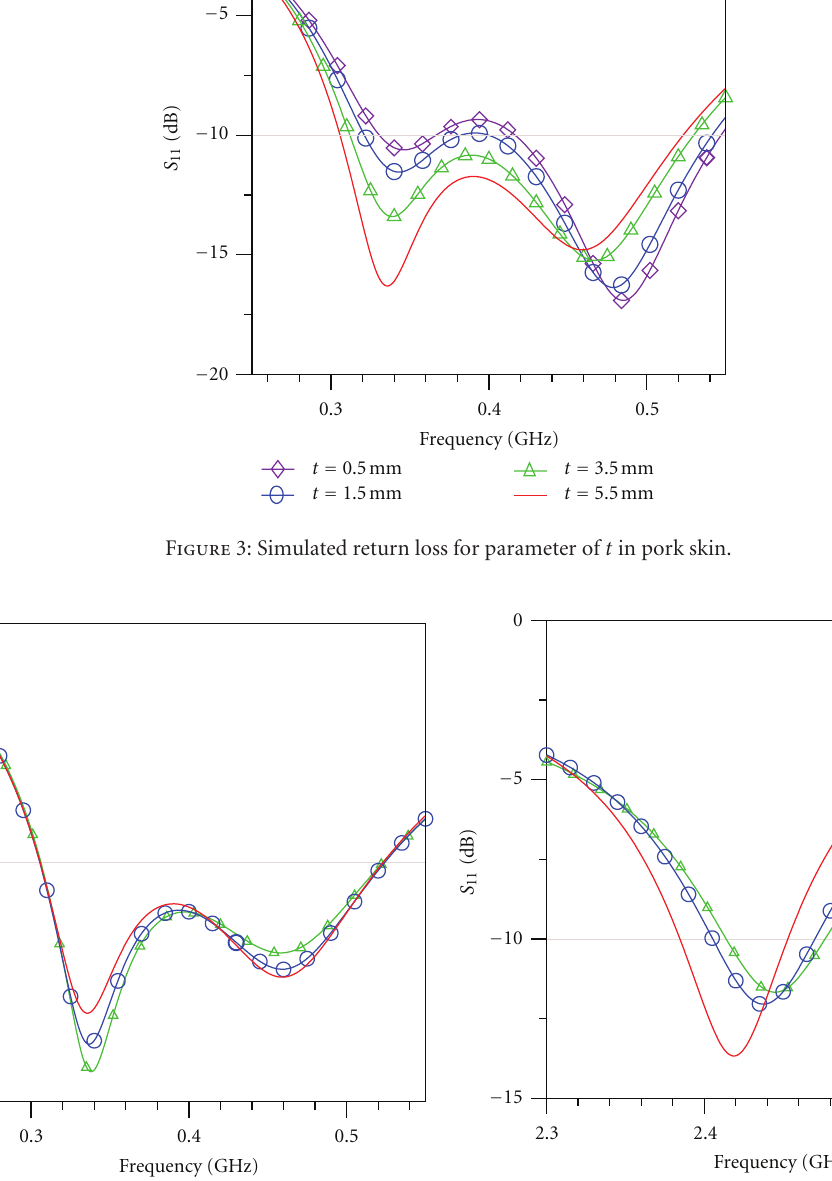
is shown in Figures 8(a) and 8(b). And the variability in the relative permittivity and conductivity of skin, muscle, and pork skin at MedRadio band, WMTS band, and two ISM bands is listed in Table 1. It can be found that the permittivity of ground port skin is close to human skin and very